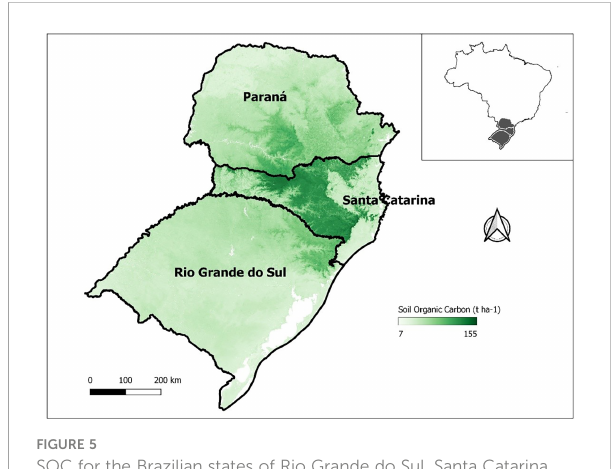
FIGURE 5 SOC for the Brazilian states of Rio Grande do Sul, Santa Catarina, and Parana ́ . Source: own elaboration in QGis v. 3.26.2 (2022) based on the Global Soil Carbon Map (84). The map in the upper right indicates the location of the states in Brazil.